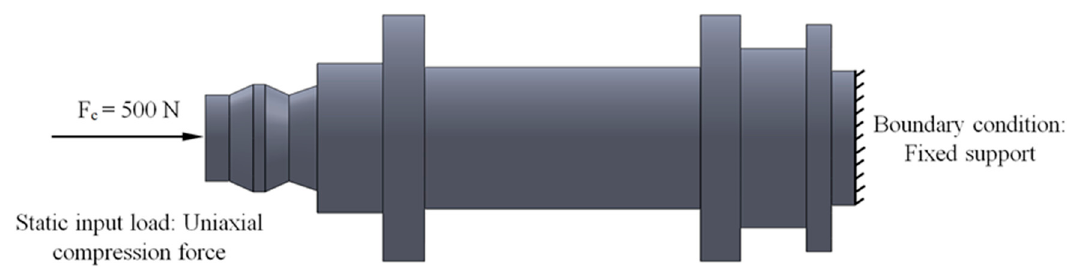
Figure 4. Requirements and load definition for the printed part.